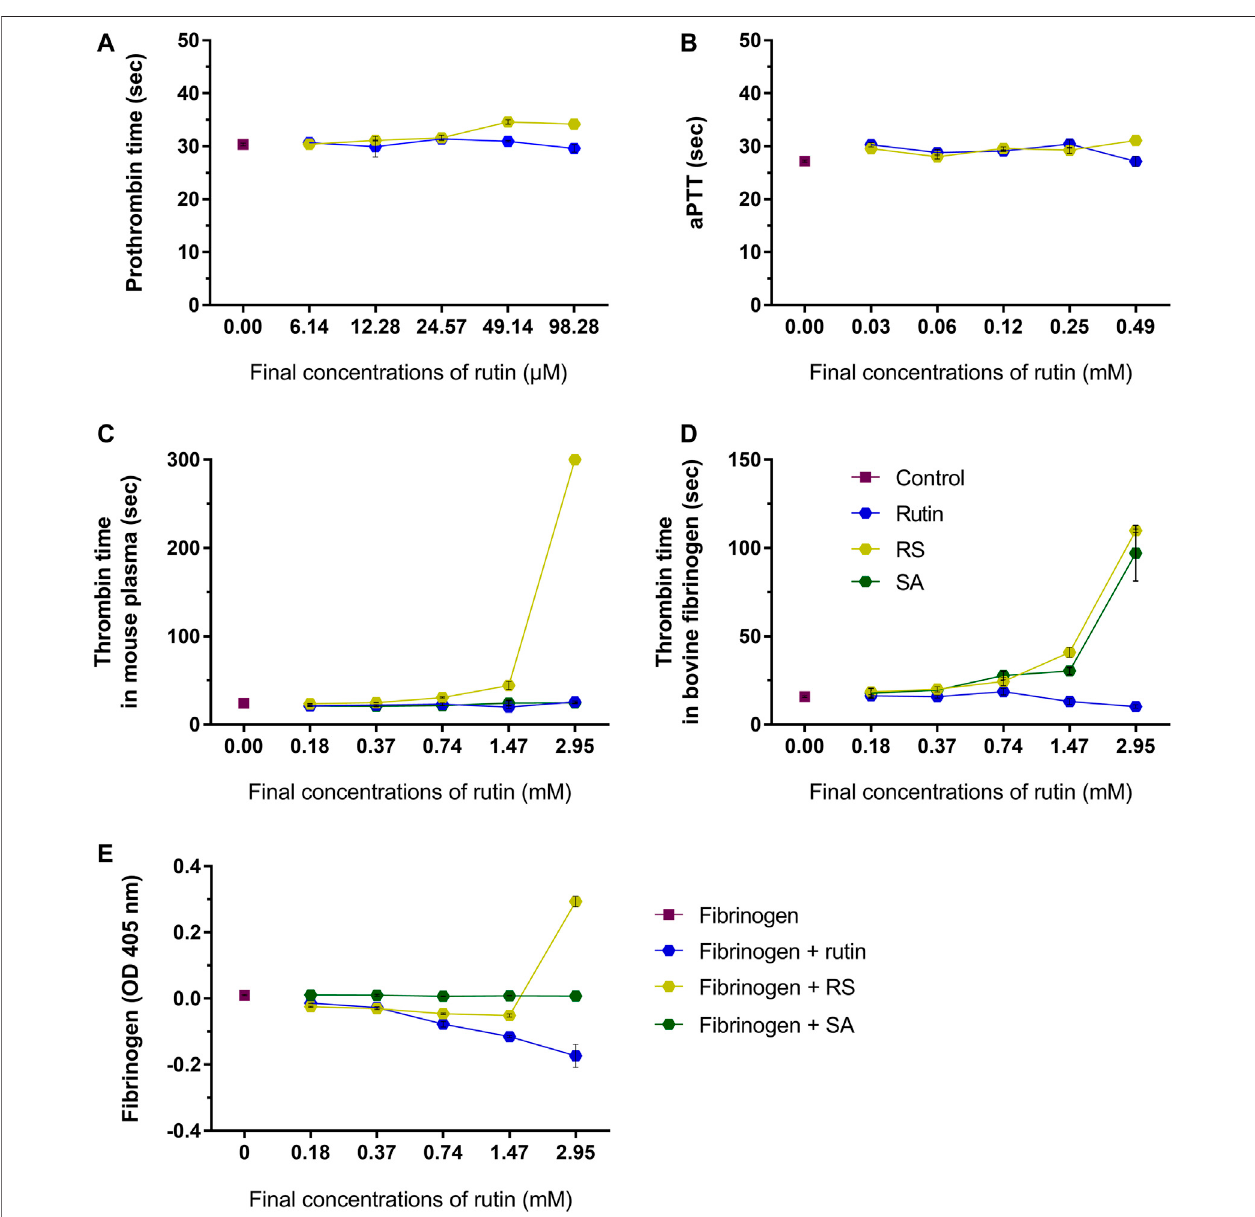
FIGURE5 | Activity of rutinand RS at different concentrationson (A) prothrombin time in mouse plasma; (B) aPTT inmouse plasma. Activity ofrutin,RS and SAat different concentrations on (C) thrombin time in mouse plasma; (D) thrombin time in bovine fi brinogen; (E) formation of complexes with fi brinogen. Data are representative of assays in